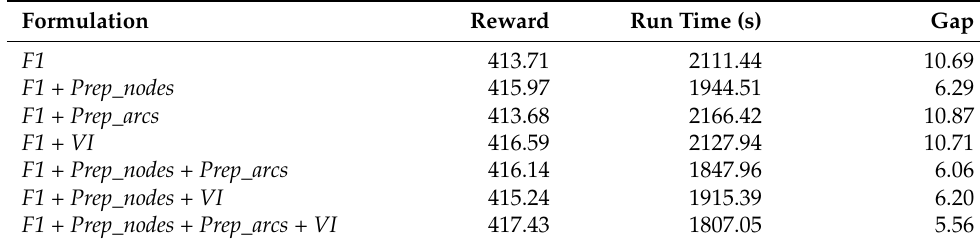
Table 1. Results obtained for 59 out of 60 p 3 instances.